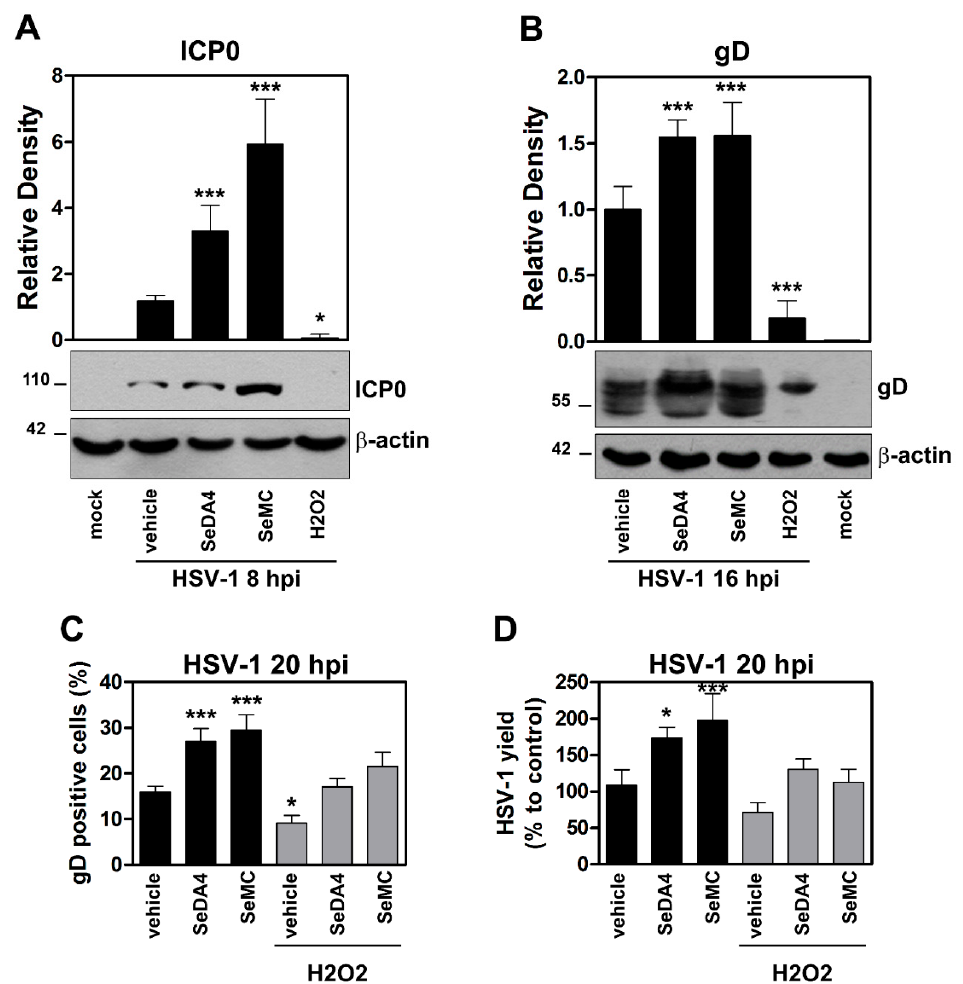
Figure 7. E ff ects of ROS-modulating agents on HSV-1 replication. U937 cells were pre-incubated with selenium-based antioxidants (SeDA4 or SeMC 20 µ M) for 48 h and / or exposed to H 2 O 2 for a further 30 min before infection with HSV-1 (MOI 50 PFU / cell). At the indicated times, cells (hpi) were collected and assayed for virus replication by di ff erent techniques. ( A , B ) Western blot analysis of ICPO ( A ) and gD ( B ) viral proteins from samples pre-incubated with antioxidants or complete media (vehicle) before exposure to H 2 O 2 and infection. Mock-infected cultures were also included. Top panels: densitometric analysis normalized to β -actin expression and expressed as mean + S.D. of data obtained from two evaluations in duplicates. Bottom panels: representative gels. ( C ) Immunofluorescence microscopy analysis of gD expressing cells from samples pre-incubated with antioxidants or complete medium (vehicle) before exposure to H 2 O 2 and infection. Analysis by IFA is expressed as % positive cells (mean + S.D.) calculated from 20 di ff erent fields per conditions of four separate experiments (5 fields each). ( D ) Virus yield in supernatants determined by plaque assay in samples obtained from the same experiments of C. Data are expressed as percentage of HSV-1 yield with respect to infected, untreated cells (vehicle). * p < 0.05, ** p < 0.001, *** p < 0.0001 versus HSV-1-vehicle treated groups (only infected groups are